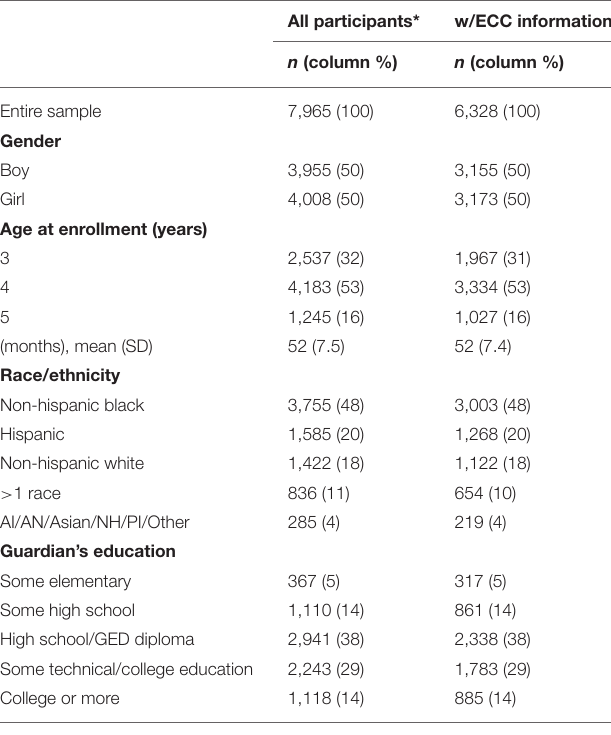
TABLE 1 | Sociodemographic information of the ZOE 2.0 study participants, overall and among those with clinical information for early childhood caries